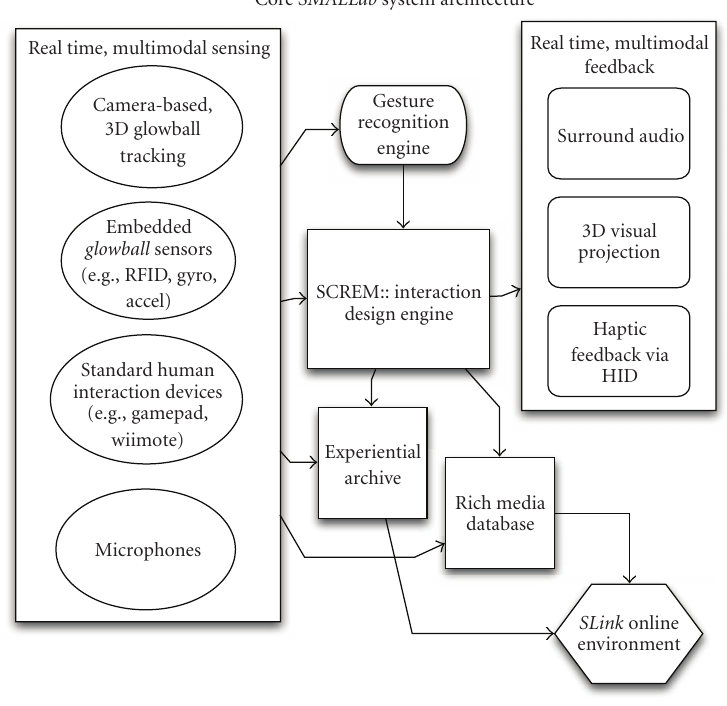
Figure 2: SMALLab software